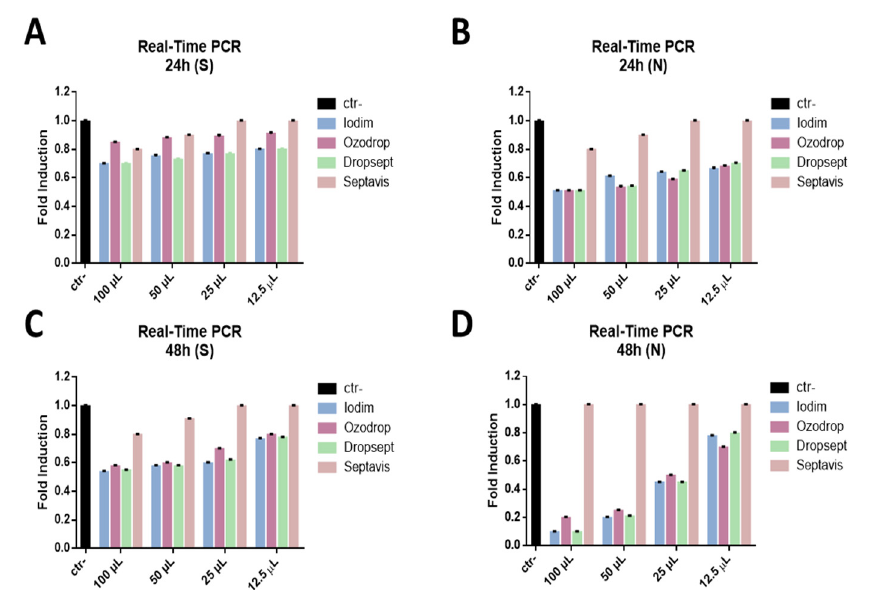
Figure 6. Molecular assay. Real-time PCR was performed to evaluate the effect of eye drops on the viral gene expression. Iodim ( A ), Ozodrop ( B ), Dropsept ( C ), and Septavis ( D ) were tested at different volumes (from 100 to 12.5 uL), for 2 h stimulation at 24 and 48 h p.i. The expression of the spike glycoprotein (S) ( A , B ) and nucleocapsid protein (N) ( C , D ) was analyzed. Ctr- refers to infected but not treated cells.